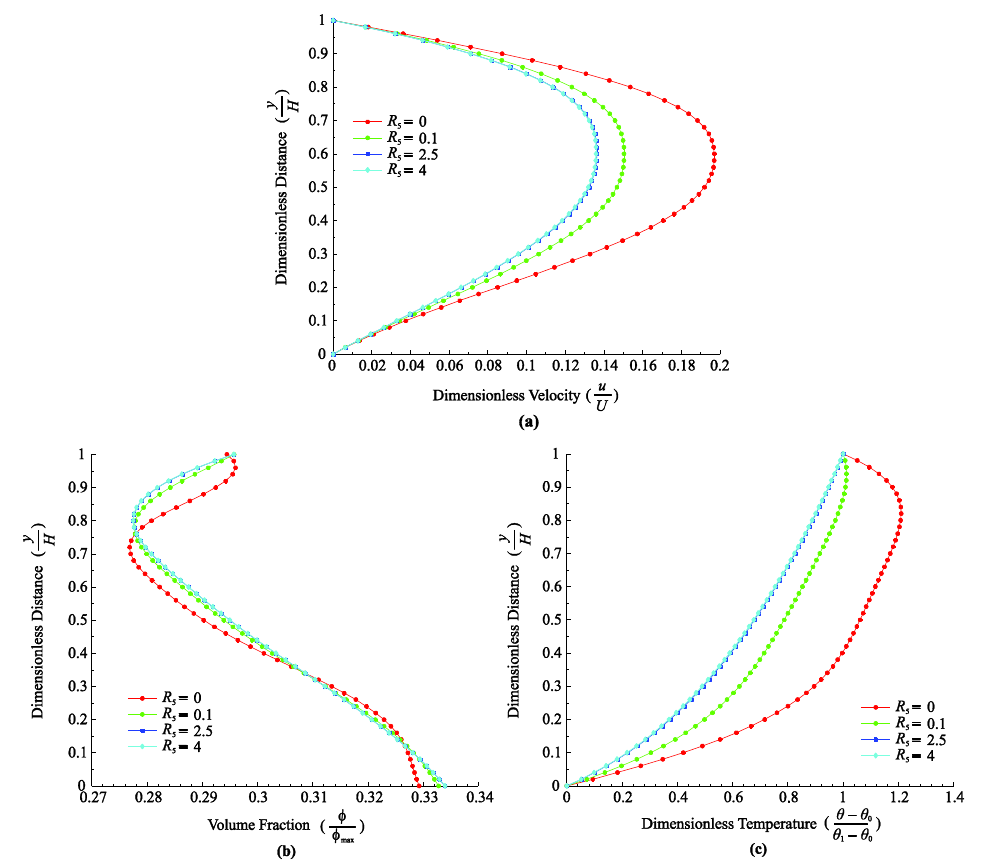
Figure 11. ( a ) Effect of 𝑅 the volume fraction distribution. ( c ) Effect of 𝑅